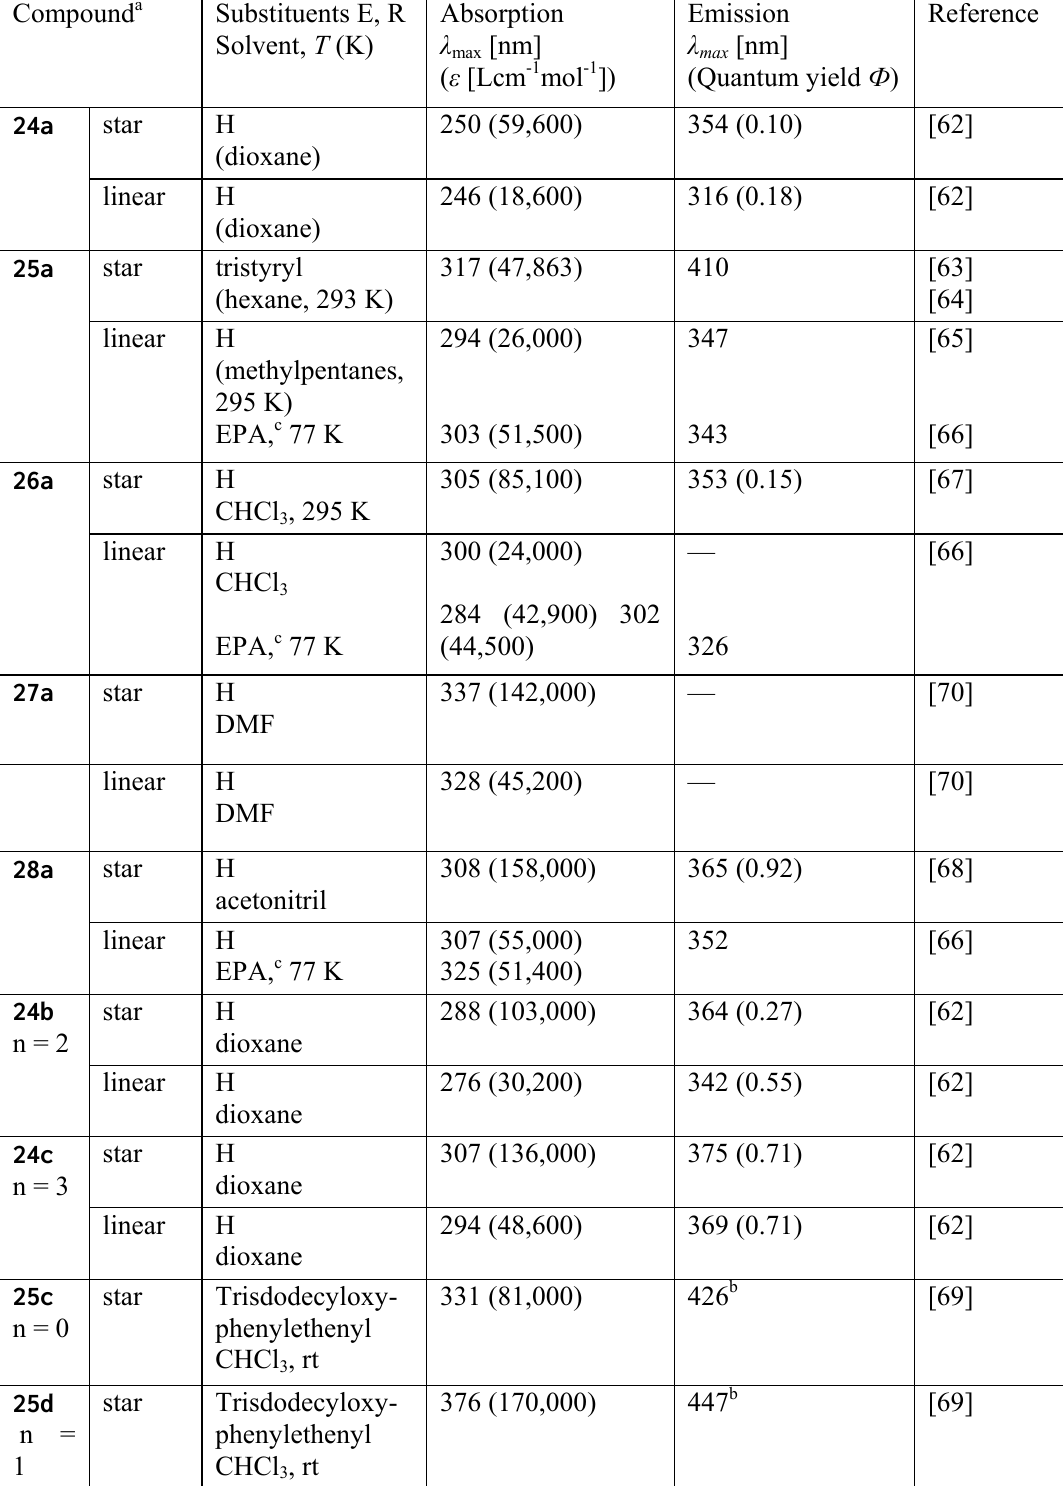
Table 2. Photophysical properties of star-shaped conjugated molecules with a 1,3,5- trissubstituted benzene